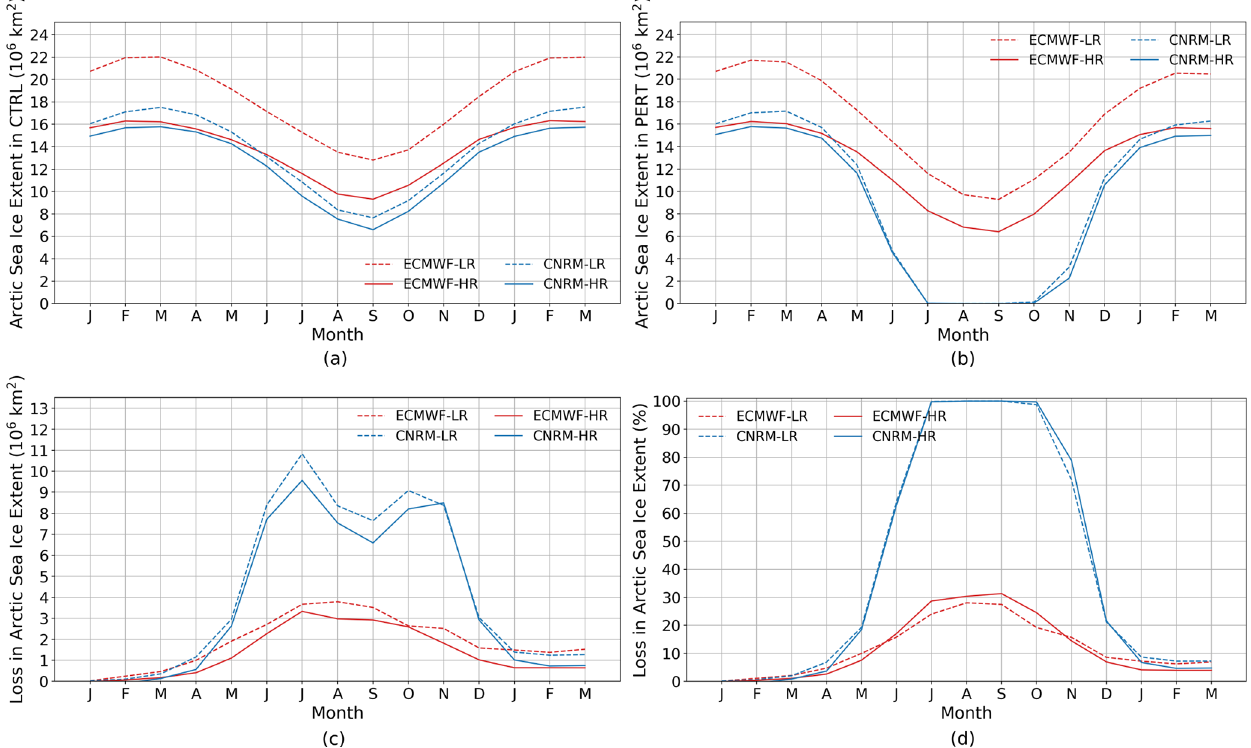
Figure 3. Arctic sea ice extent (in millions of square kilometers) in CTRL (a) and in PERT (b) . Panels (c) and (d) show the decrease in Arctic sea ice extent in PERT compared to CTRL (i.e. CTRL − PERT) in millions of square meters and in percent relative to the CTRL value,